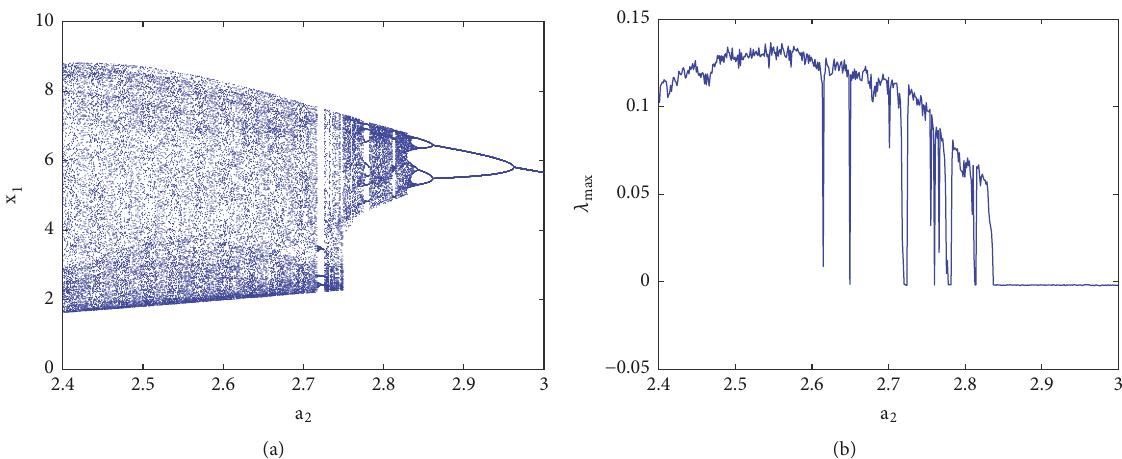
Figure 2: Backward continuation of system (3) when decreasing a 2 from 3 to 2.4 (a) and the corresponding graph of largest Lyapunov exponent ( 𝜆 max ) plotted in the range 2.4 ≤ a 2 ≤ 3